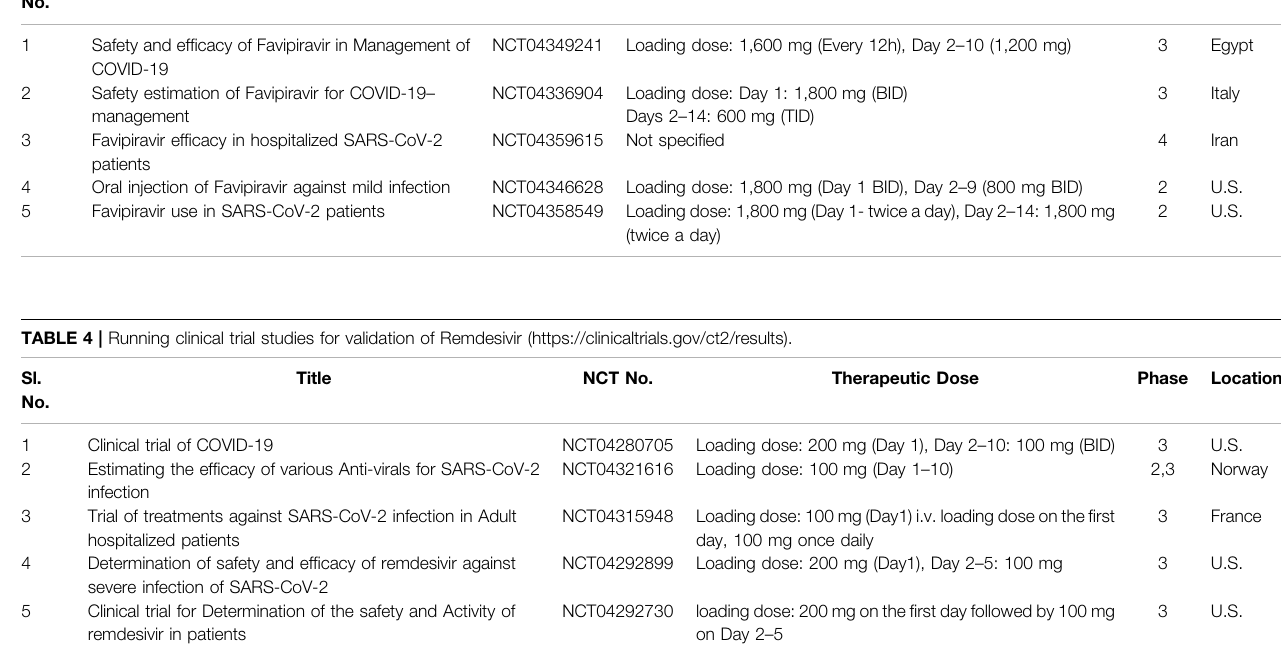
TABLE 3 | Running clinical trial studies for validation of Favipiravir (https://clinicaltrials.gov/ct 2/results). Sl. No.